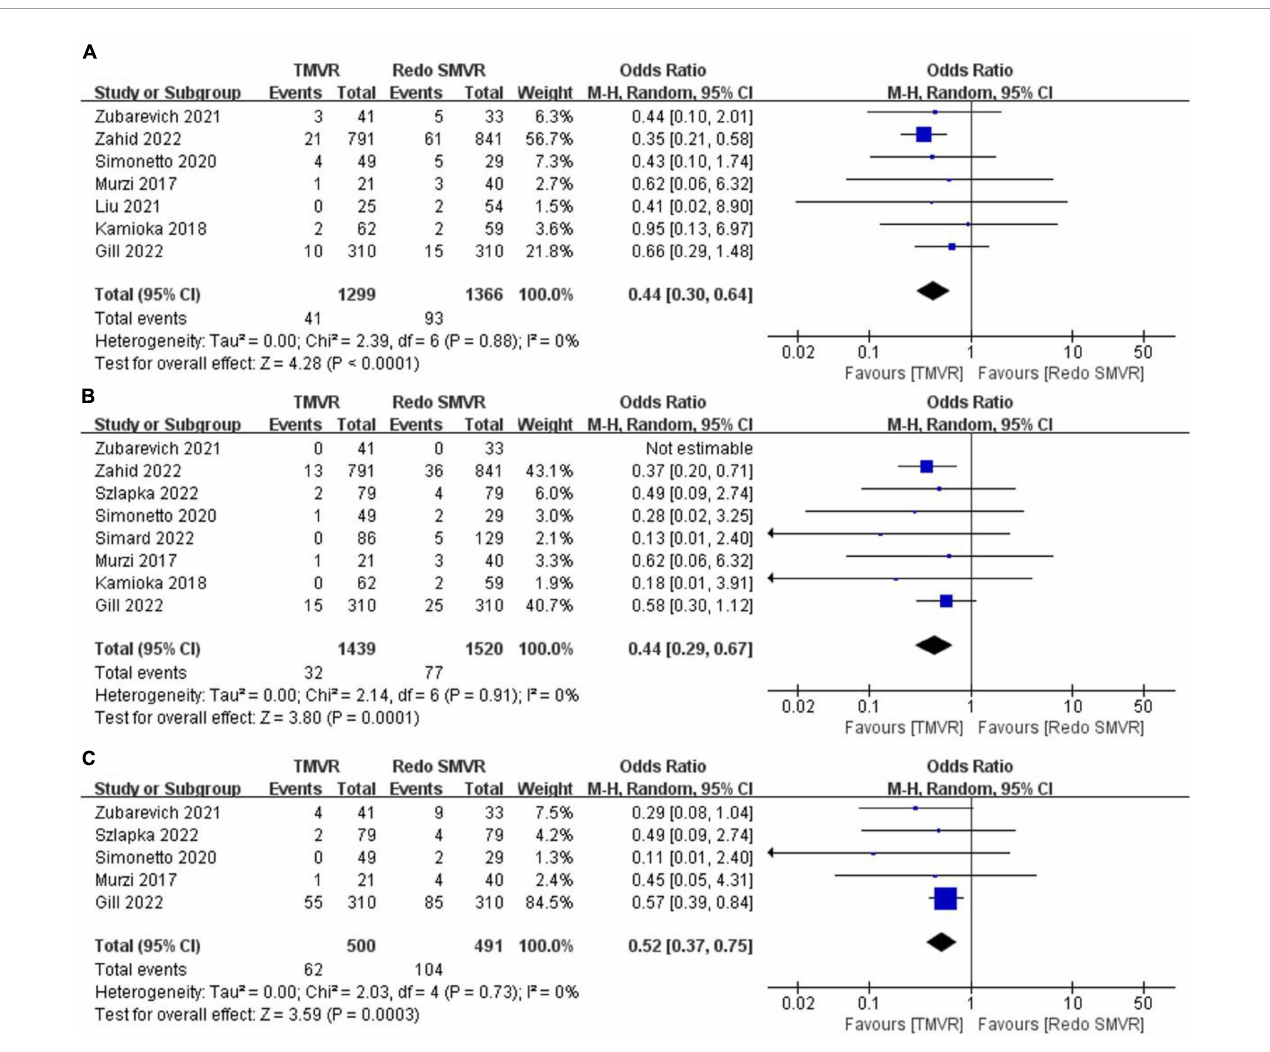
FIGURE2 Forest plot comparing TMVR with redo SMVR for (A) in-hospital mortality, (B) stroke, and (C) renal dysfunction. CI, confidence interval; df, degrees of freedom; MH, Mantel–Haenszel.